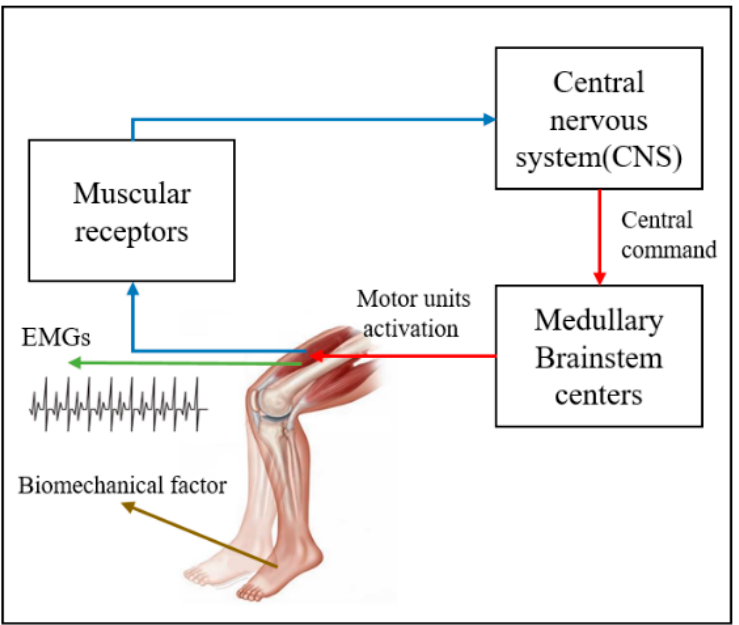
Figure 3. EMGs associated with the generation of muscle force.